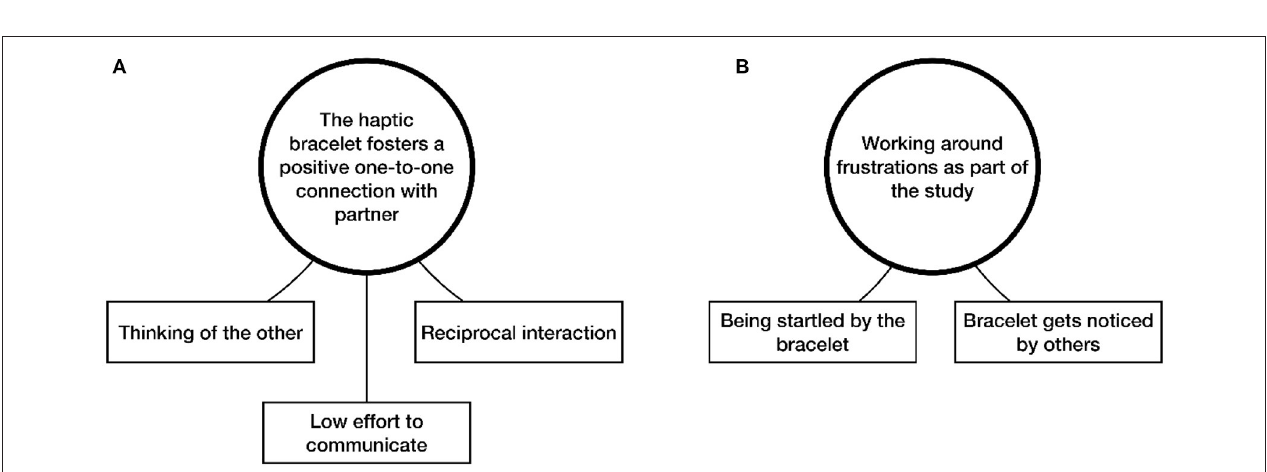
FIGURE 4 | Final thematic map, showing the two main themes derived from thematic analysis. (A) The first main theme with its three subthemes and (B) the second main theme and its two subthemes.